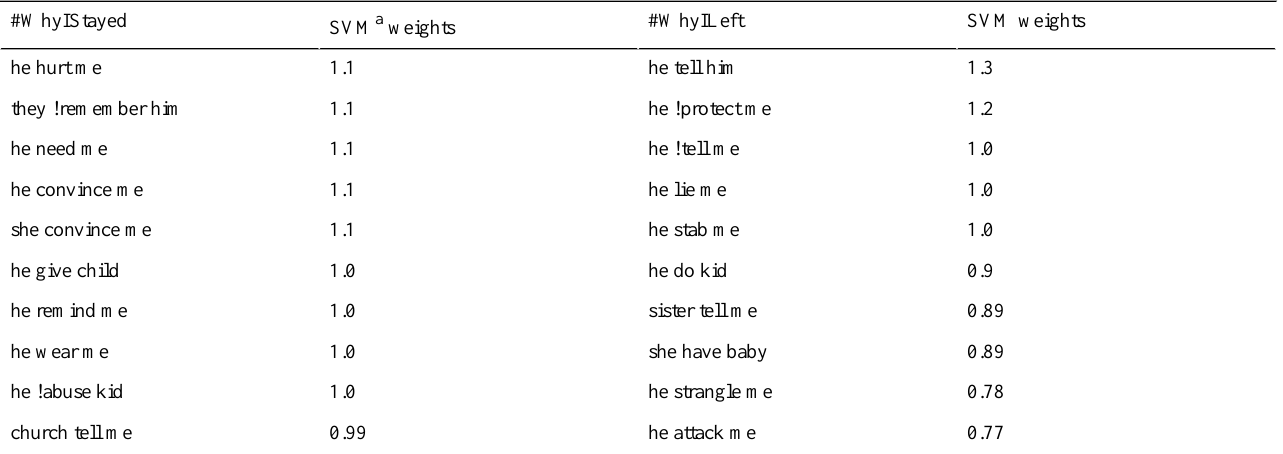
Table 7. Top 10 subject-verb-object features for #WhyIStayed and #WhyILeft, with their support vector machine weights. An exclamation point (!) in front of a predicate verb indicates